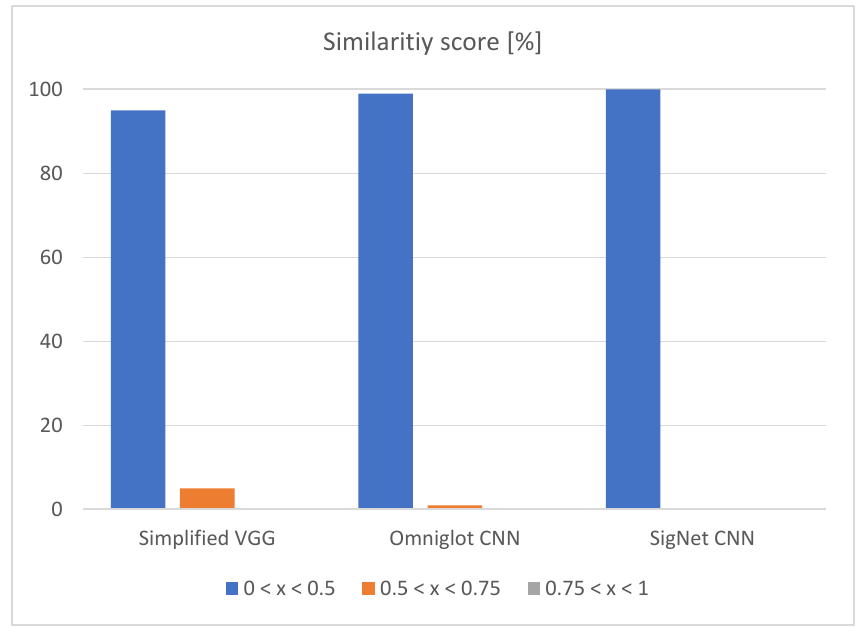
Figure 5. Input vs. random train image from each class — similarity score.